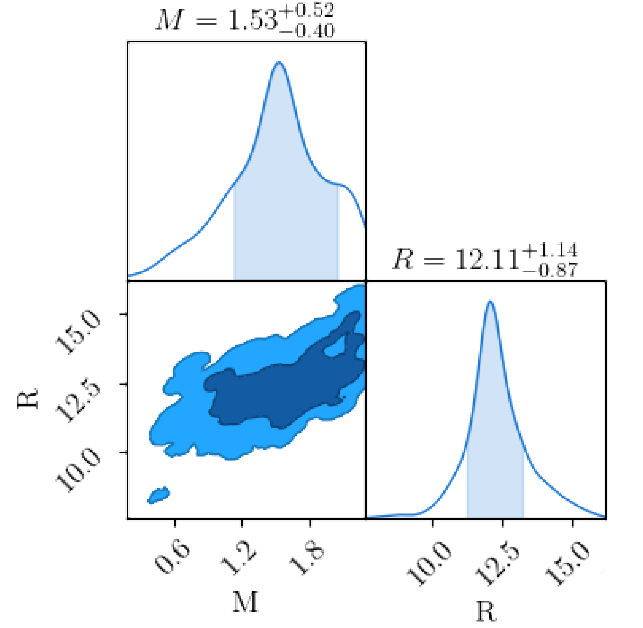
Figure 5. Parametric space at 1 σ CL and one-dimensional marginalized distribution of M and R for two hot spots on the surface of 1A 0535+262. For completeness, M and R are measured in units of M (cid:12) , and km, respectively. The dark (light) blue shows the parametric space at 1 σ (2 σ ) CL.